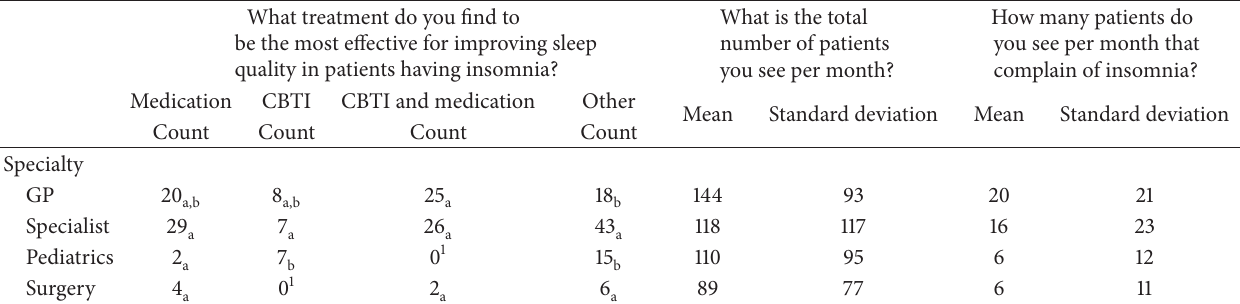
Table 1: Referral practices for insomnia treatment and patient volume by physician specialty. What treatment do you find